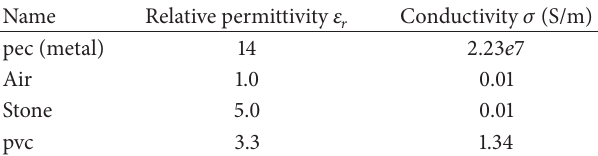
Table 2: Parameters of the four